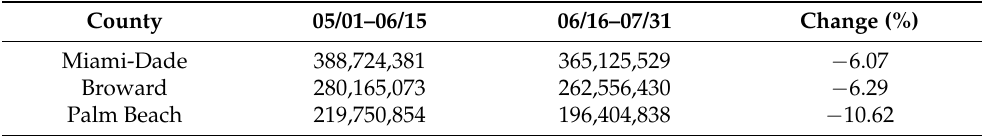
Table 4. Total inflow trips for 05/01–06/15/2020 and 06/16–07/31/2020 for Miami-Dade, Broward, and Palm Beach